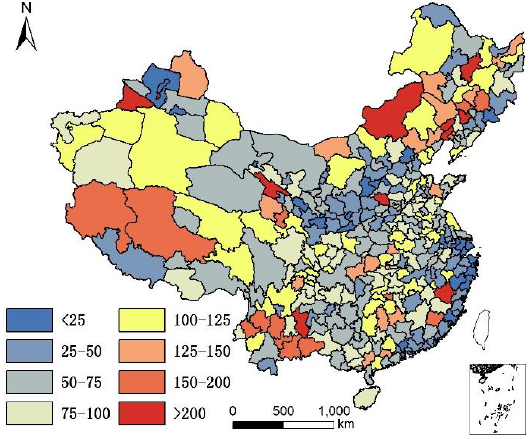
Figure 9. Per capita meat production of each city in China in 2016 (kg).